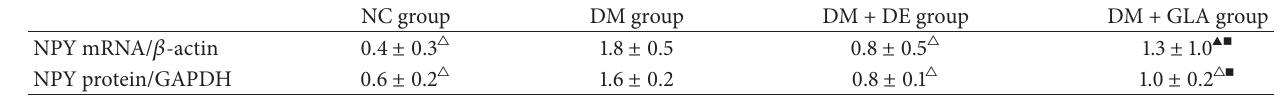
Table 4: The relative amount of NPY mRNA and protein ( 𝑥 ± 𝑠 ).